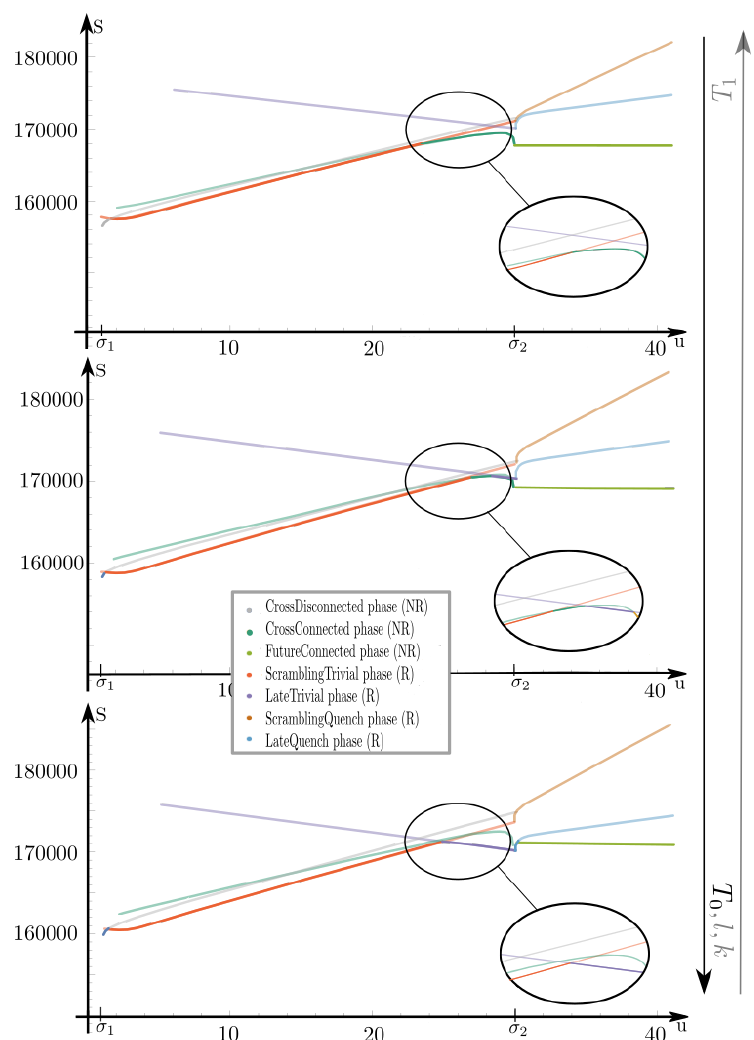
Figure 14. This figure shows the general shape of the competing saddles at intermediate and late times for the entanglement entropy of QM L +finite segment of radiation in the bath depending on the values of the free parameters in the theory. Specifically, we used different values of T 0 . Namely, we used T 0 = 449 for the upper plot, T 0 = 453 , 5 for the middle plot and T 0 = 459 for the lower plot, 512 π 512 π 512 π in order to illustrate the different scenarios. The entanglement entropy is obtained by minimizing between the different saddles. Transparent colors are used to illustrate saddles outside of their regimes of dominance. The values of the other parameters used in this plot can be found in table